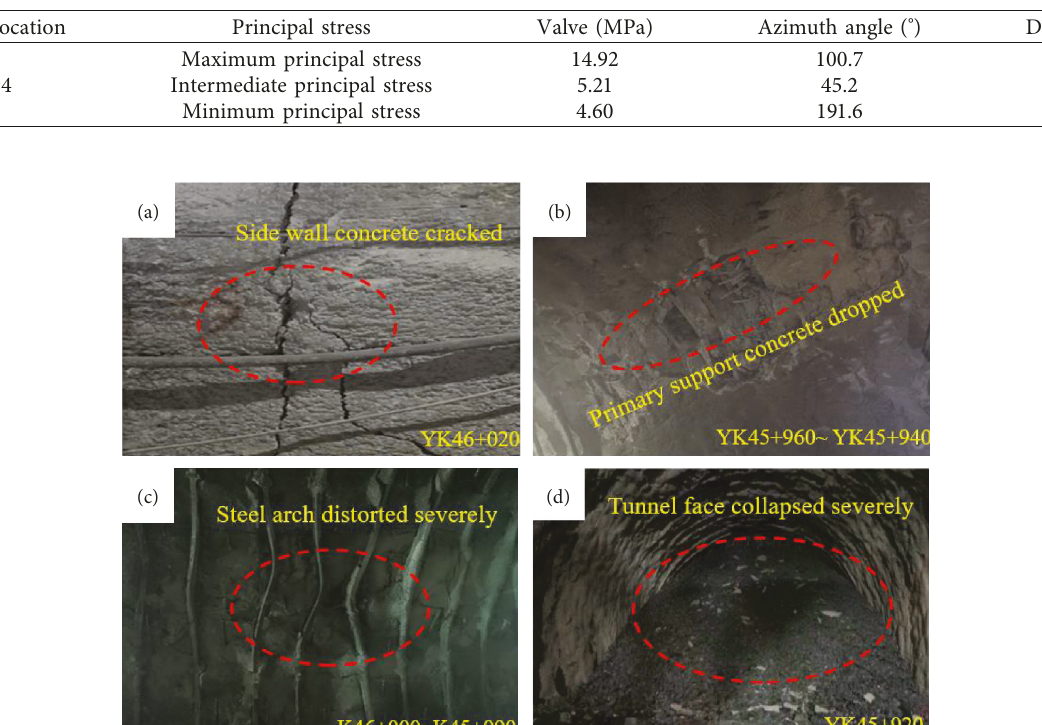
Figure 2: Damaging phenomena caused by large deformation of soft rock under high geo-stress: (a) side wall concrete cracked; (b) primary support concrete dropped; (c) steel arch distorted severely; (d) tunnel face collapsed severely.